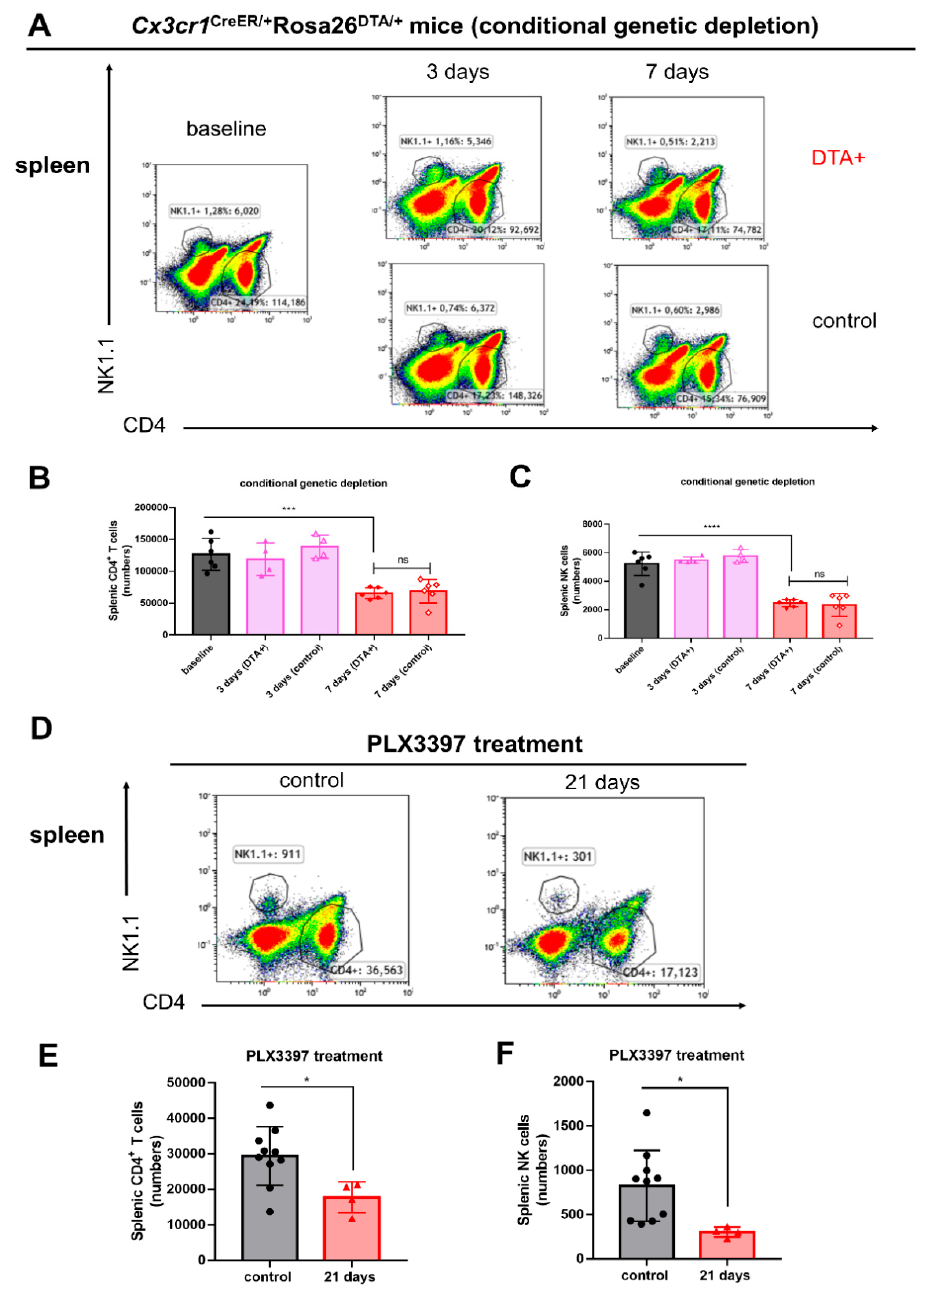
Figure 4. Splenic CD4 + T cells and NK cells are affected following conditional genetic and pharmacological microglial depletion. ( A ) Representative flow cytometry plots of splenic CD4 + T cells and NK1.1 + cells in Cx3cr1 CreER/+ Rosa26 DTA/+ and Cx3cr1 CreER/+ mice 3 and 7 days after tamoxifen injections. ( B , C ) Quantitative analysis of splenic CD4 + T cells and NK1.1 + cells ( ± SEM) during conditional genetic microglial depletion periods (baseline, black bars; day 3, pink bars; day 7, red bars, n = 6, 4, 4, 6, 6, respectively). ( D ) Representative flow cytometry plots of splenic CD4 + T cells and NK1.1 + cells in C57BL / 6NTac mice following PLX3397 diet (21 days) at a dose of 290 mg / kg. Control mice were treated with normal diet. ( E , F ) Quantitative analysis of splenic CD4 + T cells and NK1.1 + cells ( ± SEM) during pharmacological microglial depletion periods (control, black bars; day 21, red bars, n = 10, 4, respectively). Statistical significance is indicated as * p < 0.05, *** p < 0.001 and **** p < 0.0001 (ns: not